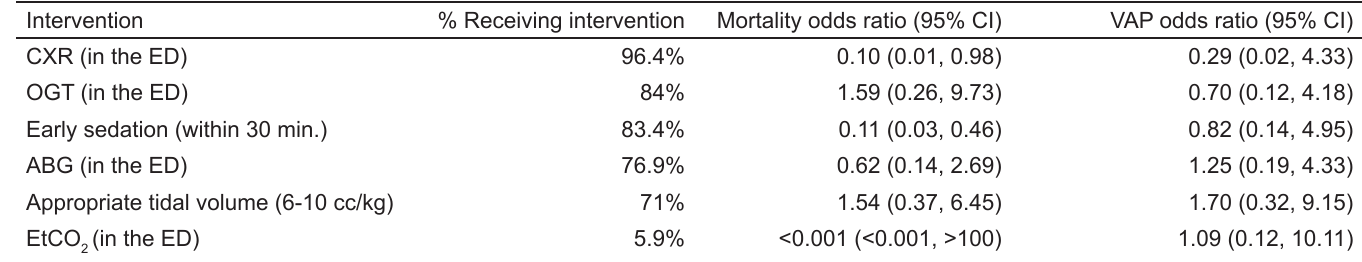
Table 2. Multivariate logistic regression of interventions with mortality and VAP adjusted for SOFA and APACHE II score. Intervention